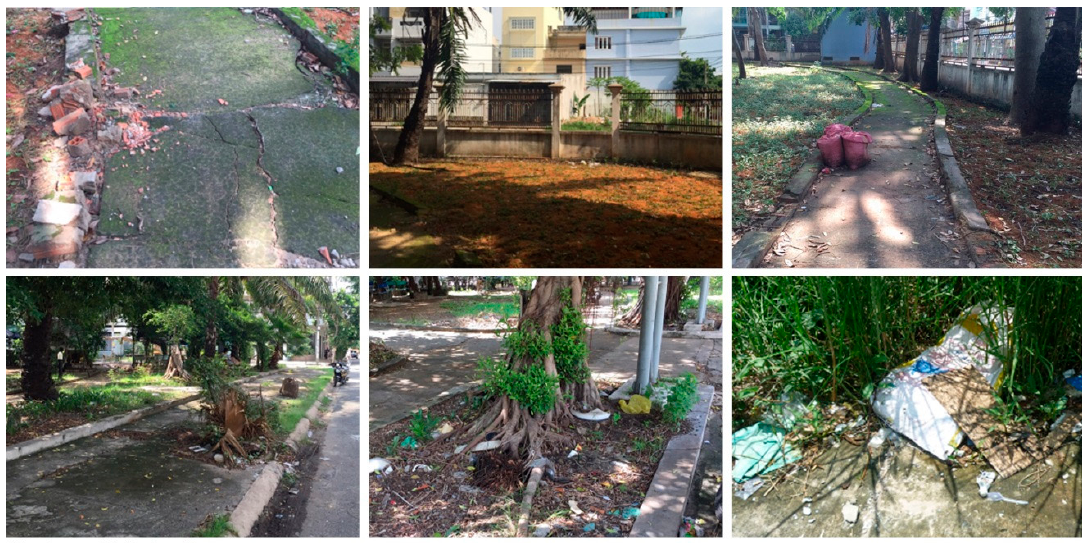
Figure 2. Figurations of damaged parks (in terms of deterioration and cleanliness).